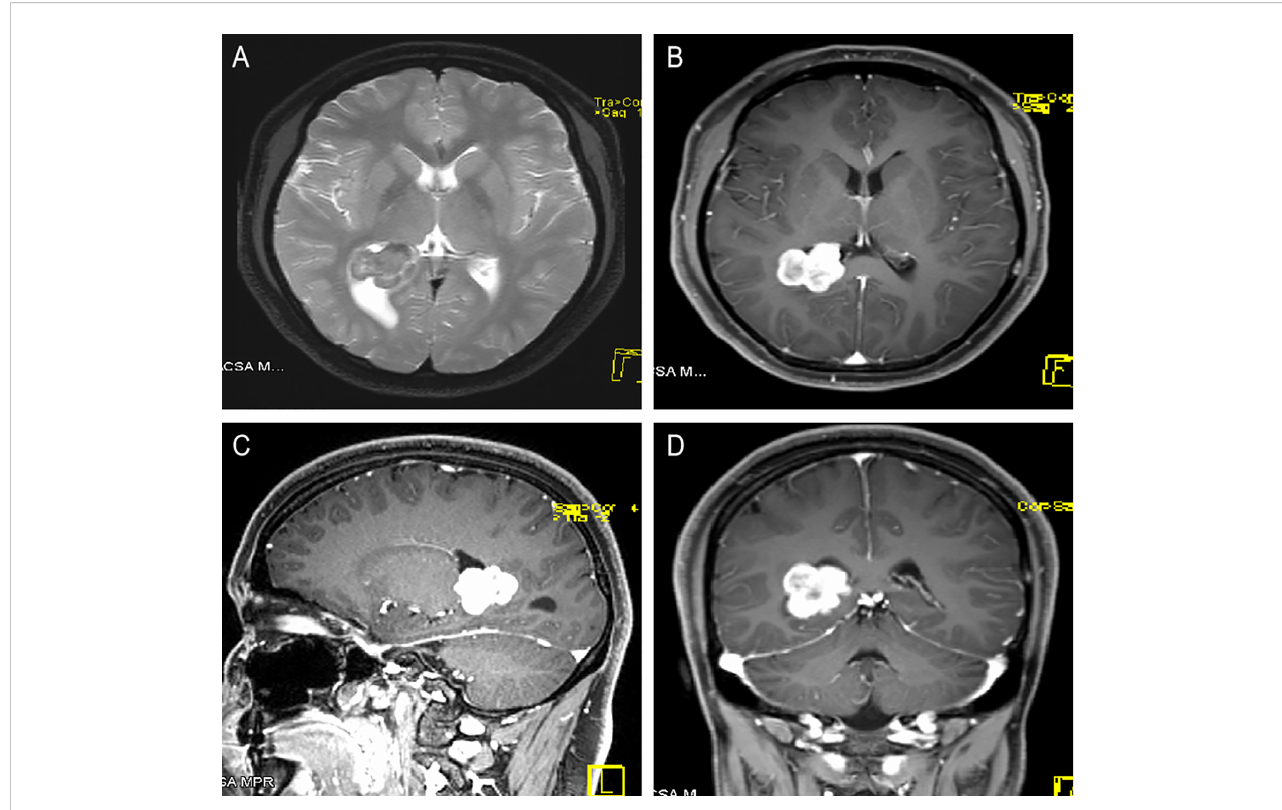
FIGURE 1 A 22-year-old woman with right LVES. (A) Axial T2WI scan showed an approximately 3.0 cm × 2.5 cm × 2.5 cm irregular cystic-solid lesion at the posterior horn of the right lateral ventricle, intimately related to the choroid plexus, with mild peritumoral edema. The solid components exhibited low signa on T2WI, and the cystic components presented hyperintense signals on T2WI. (B – D) Axial, sagittal and coronal contrast-enhanced T1WI showed heterogeneous and apparent enhancement of the solid part of the mass but no obvious enhancement in the cystic part.